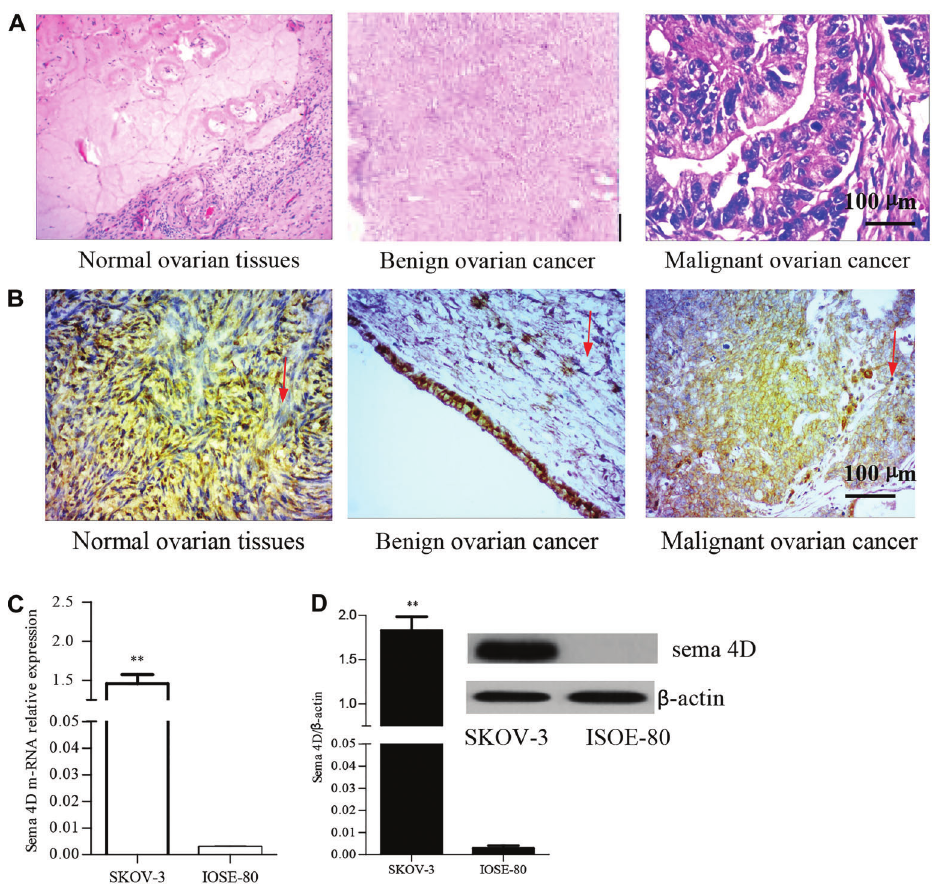
Figure 1. Semaphorin 4D (sema 4D) was up-regulated in ovarian tissues and cells. A , HE staining. B , sema 4D protein expression levels in ovarian cancer and normal ovarian tissues by immunohistochemistry. The arrows indicate sites of sema 4D expression. C , sema 4D m-RNA level using RT-PCR. Cells were harvested and total RNA was extract after 72 h culture. D , sema 4D protein level by western blotting. b -actin was used as an internal standard. SKOV-3: human ovarian cancer cells; IOSE-80: human normal ovarian cells. The experiments were repeated three times. Data are reported as means ± SD (**P o 0.01, t (Figure 3A). Counting analysis indicated that more than down-regulated accompanied by an up-regulation of 75% SKOV-3 cells were successfully transfected by 293T- ER a protein expression in SKOV-3 cells. The expressive pLV-ER a or 293T-pLV-ER b . After 72 h transfection and partners of ER a and ER b were differential and opposite in culture, RT-PCR and western blotting were conducted to SKOV-3 and ISOE-80 cell lines. analyze the ER a and ER b expression level in ER a + , ER b + , and CK SKOV-3 cell lines. The results of RT-PCR showed the ER a m-RNA expression level in ER a + SKOV- 3 cell lines was signi fi cantly higher than in ER b + and CK SKOV-3 cell lines (Figure 3B). ER a protein expression in ER a + SKOV-3 was also signi fi cantly higher than in ER b + and CK SKOV-3 cell lines by the western blotting analysis (Figure 3C). However, ER b levels in ER a + SKOV-3 did not exhibit signi fi cant differences compared with those in CK SKOV-3 cells. Over-expression of ER a in SKOV-3 cells did not alter ER b expression. The up-regulation of cell line co-transfected with blank plasmid showed no ER b in ER b + SKOV-3 cell line was also veri fi ed by fl uorescence under the inverted fl uorescence microscope western blotting and RT-PCR (Figure 3B and C). Since